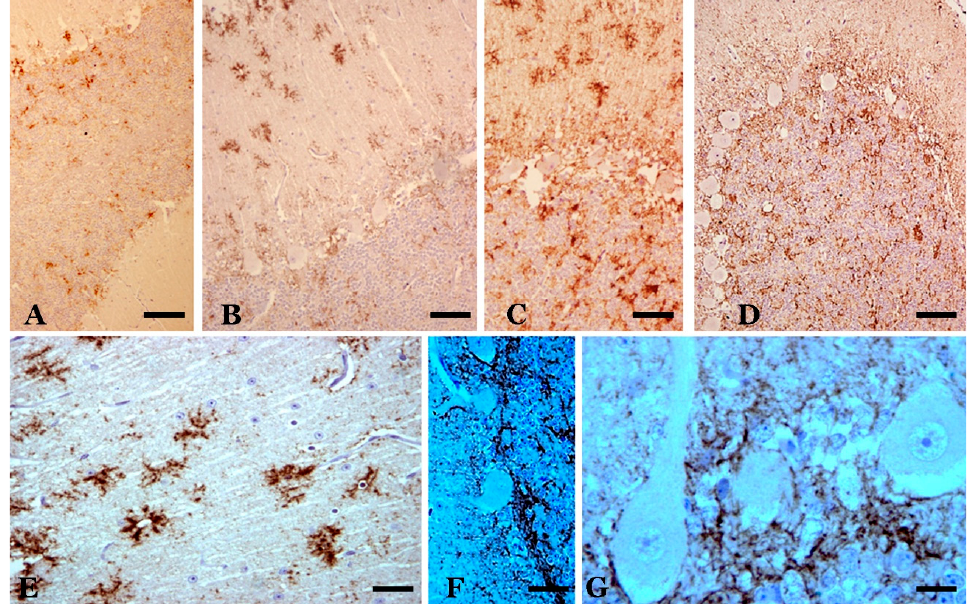
Figure 6. Abnormal PrP deposits/deposition (abnormal PrP immunoreaction—L42 1/500; Bio-Pharm, Darmstadt, Germany—plus hematoxylin contrast). ( A ) Deposits in a sheep in the preclinical phase of scrapie. Slight deposits are observed only in some folia in the layers of the cerebellar cortex. ( B , C ) Star-like deposits in the molecular layer (in B ) and various types of deposits in all layers in two cases of sheep with infection in the clinical stage. ( D ) Diffuse granular deposits in all layers of a terminal-phase sheep case. Star-like deposits do not appear. ( E – G ) Details of prion deposits in clinical phase. In ( E ), star-like deposits are seen, which suggest association with non-GFAP-immunopositive astroglial cells. Hematoxylin-stained glial nuclei are seen in some of these deposits. In ( F ), a high degree of coalescence of the granular deposits is observed in the basal area of the Purkinje layer, similar to dense formations of astroglial processes in these areas (see Figure 4). In ( G ), a large accumulation of granular prion deposition is observed surrounding the areas of dystrophic Purkinje cells (with rarefied cytoplasm), but without the appearance of abnormal PrP immunoreaction in these cells. Abnormal PrP immunoreaction with hematoxylin contrast (in different concentrations). (Bar: A–D = 40 µ m; E = 10 µ m; F = 25 µ m; G = 10 µ